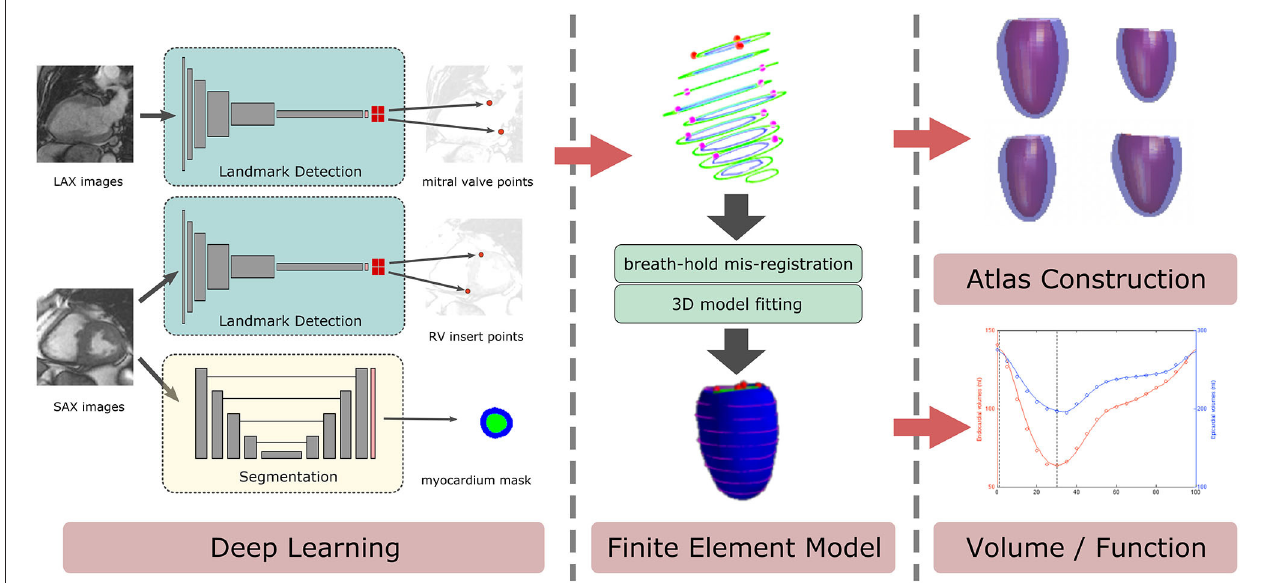
FIGURE 1 | Fully-automated atlas generation pipeline of cardiac MRI analyses. Three deep learning networks were trained to perform: (1) detection of mitral valve points from long-axis (LAX) images, from both two-chamber or four-chamber views, (2) detection of right ventricular (RV) insert points from short-axis (SAX) images, and (3) segmentation of myocardium mask from SAX images. Landmark points and contours from myocardium mask images were converted into 3D patient coordinates to guide the customization of a left ventricle (LV) model. Breath-hold mis-registration of SAX slices were corrected. The final model was used to construct a statistical shape LV